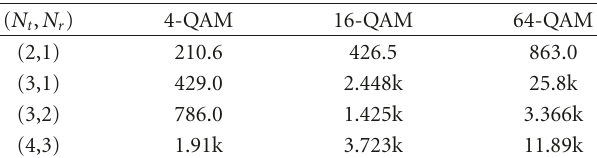
Table 2: The average number of flops for planar detection with J =